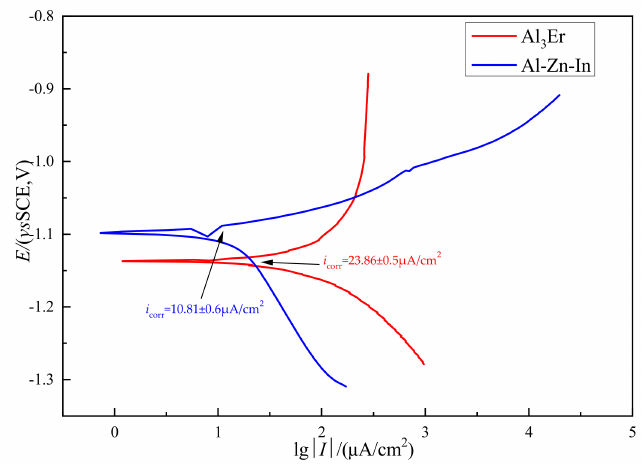
Figure 14. Polarization curves of Al–Zn–In and Al 3 Er